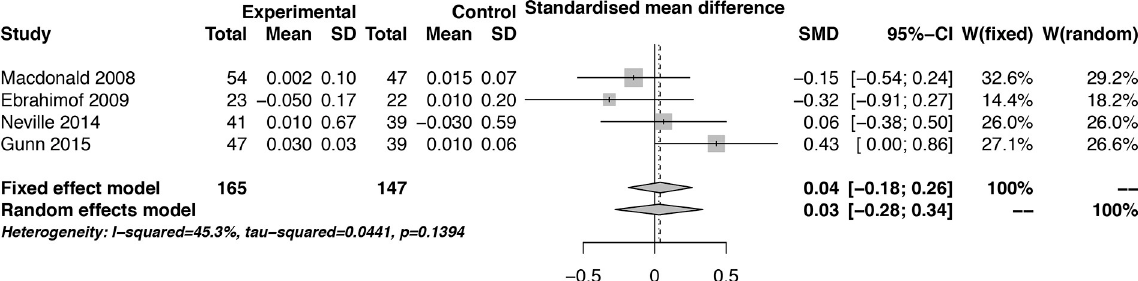
Fig 3. Forest plot of the standard means difference and 95% confidence interval of the C-terminal telopeptide after 3 months combined with fruit and vegetable intake in randomized clinical trials.